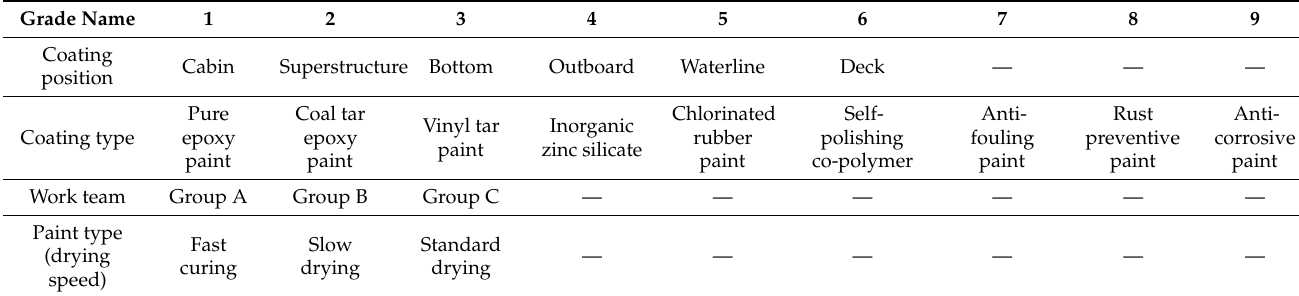
Table 2. Discrete feature ranking.